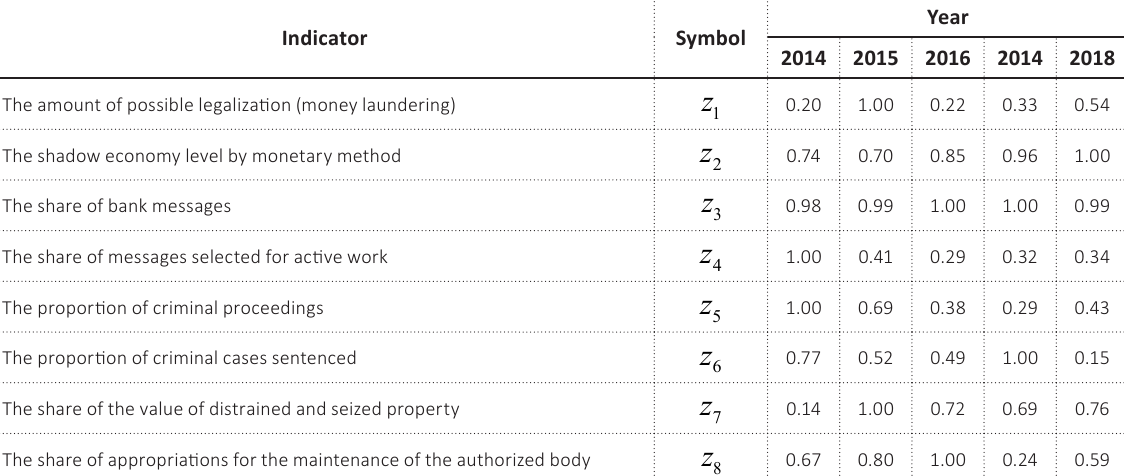
Table 2. Normalized indicators of financial monitoring effectiveness of Ukrainian banks in 2014–2018